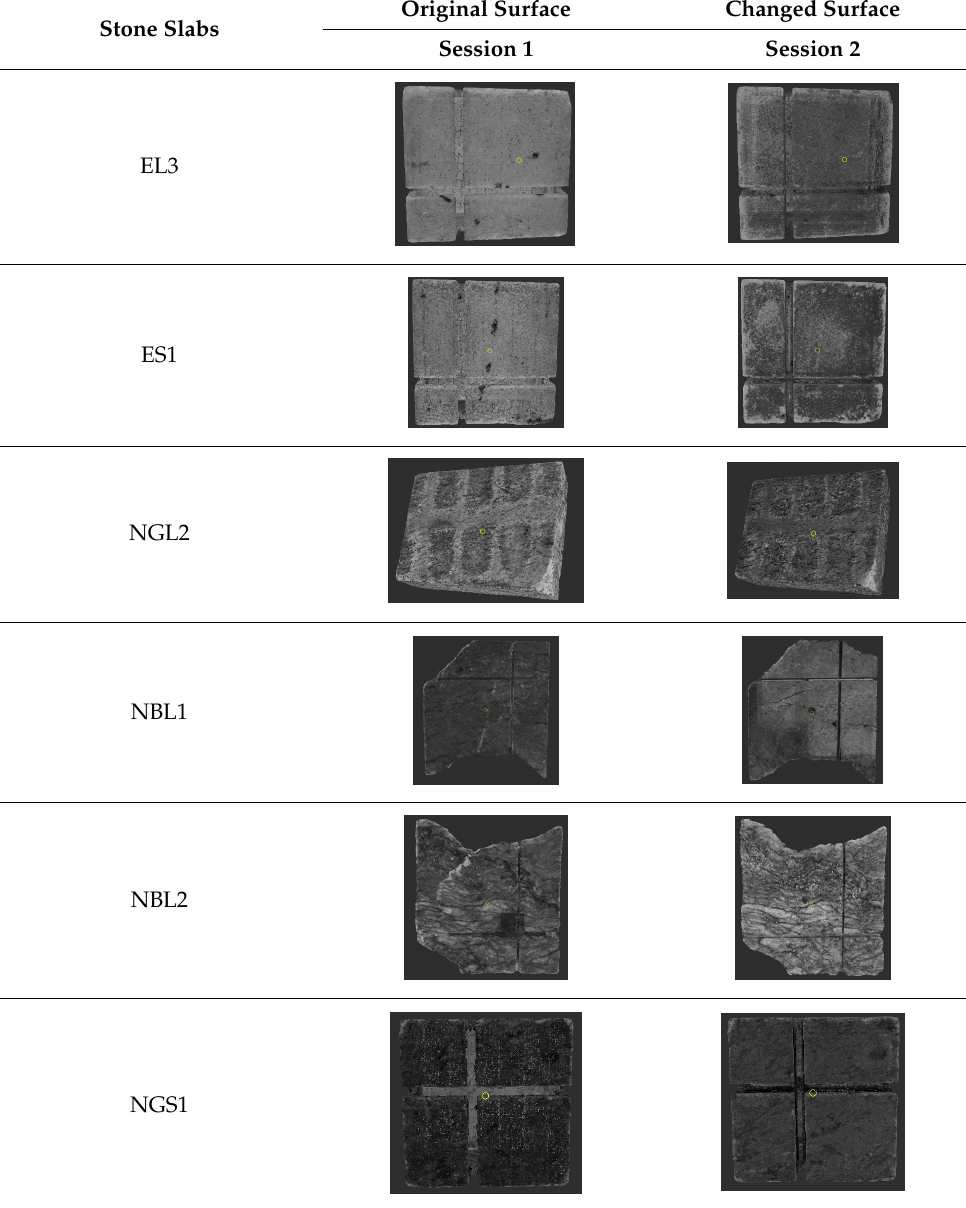
Table 9. Three-dimensional models of the considered stone slabs from two different times. Stone Slabs